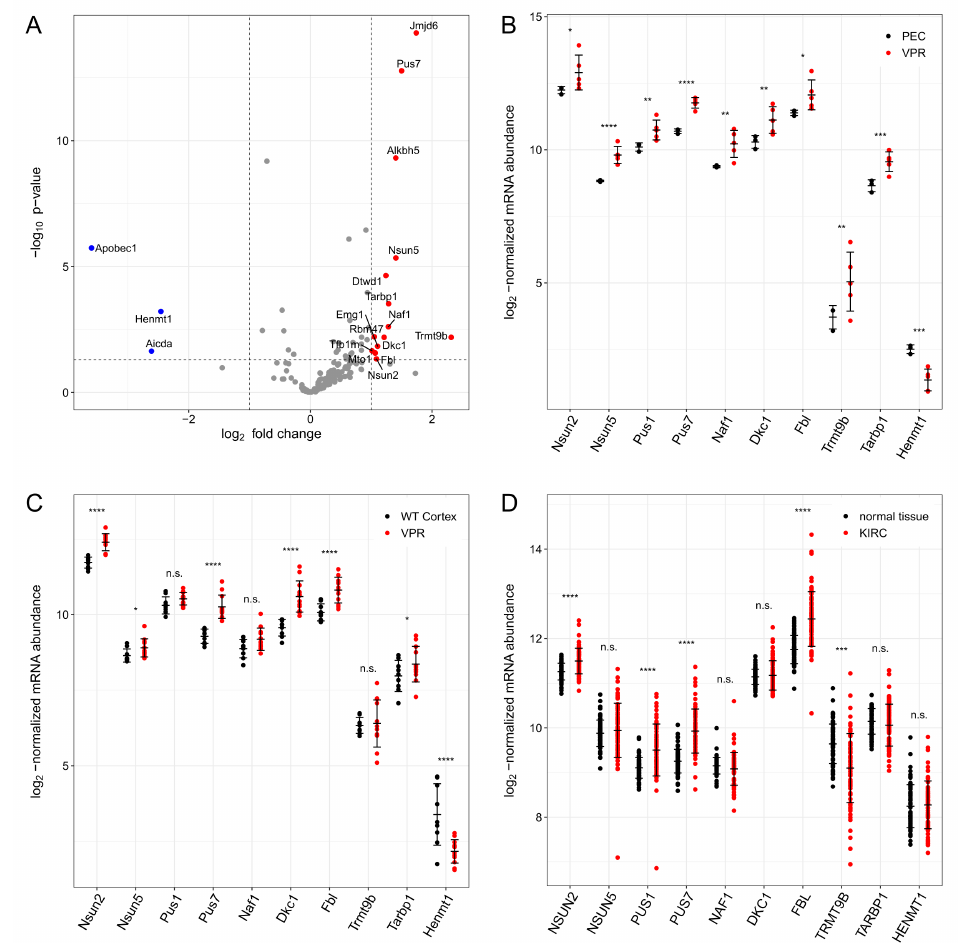
Figure 5. Analysis of RNA-modification genes. ( A ) The log 2 -fold changes (5 VPR cell lines compared to 3 PEC samples) and corresponding p -values of 152 genes involved in RNA modification are plotted. The 3 genes that decreased more than two-fold are depicted in blue and the 15 genes that increased more than two-fold are labeled in red. The dashed lines indicate the log 2 fold change cut-offs (vertical lines at − 1 and 1) and p -value cut-off (horizontal line at 0.05). Statistics were obtained using DESeq2. ( B – D ) The log 2 -normalized mRNA abundance is shown in the same VPR cell lines (N = 5) and PEC (N = 3) ( B ), in VPR tumors (N = 12) and WT cortex (N = 9) ( C ), and in human tumors (TCGA KIRC (Kidney Renal Clear Cell Carcinoma), N = 72) and matched normal tissue (N = 72) ( D ). Only those genes are shown which match the cut-offs and which produce the detected modified nucleosides. Error bars indicate the mean and standard deviation. The p -values were obtained from DESeq2 using Wald statistics (n.s. not significant, * p < 0.05, ** p < 0.01, *** p < 0.001, **** p <